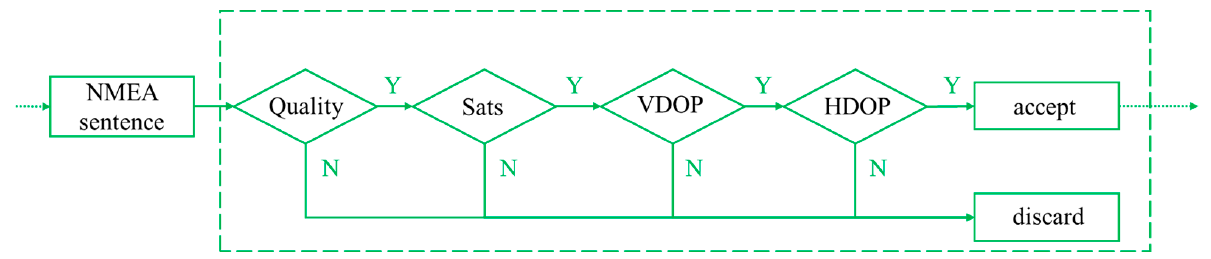
Figure 4. Filter measurement data according to GNSS metrics.